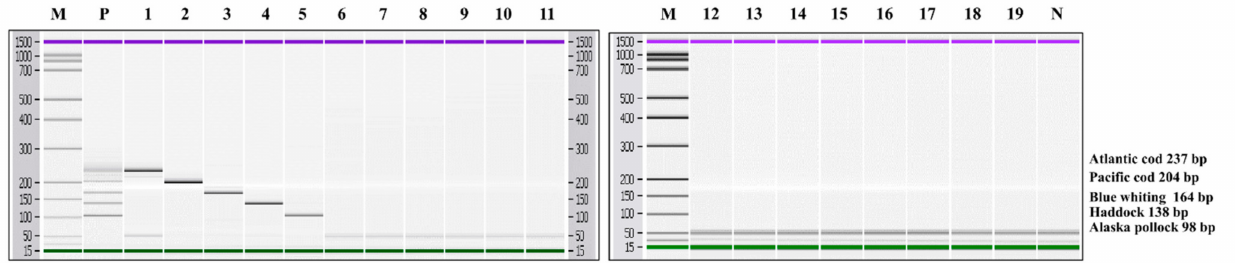
Figure 3. Specificity of the multiplex PCR assay. Lane M: 100 bp DNA ladder, lane P: positive control (10 ng of